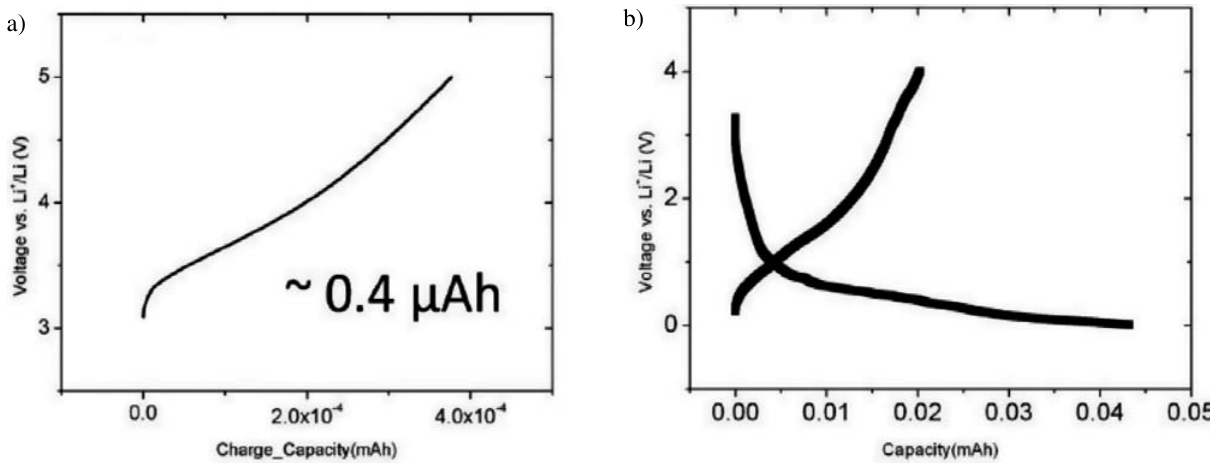
Figure 5. The first charge curve of the Li/LiF-Ti cell and the first discharge-charge curves of the Li/LiF-Ti nanocomposite cell at room temperatu- dissolved in EC: DMC, 1:1 in volume). LiF:Ti = 19:1 for atomic ratio. re in 1M LiPF 6